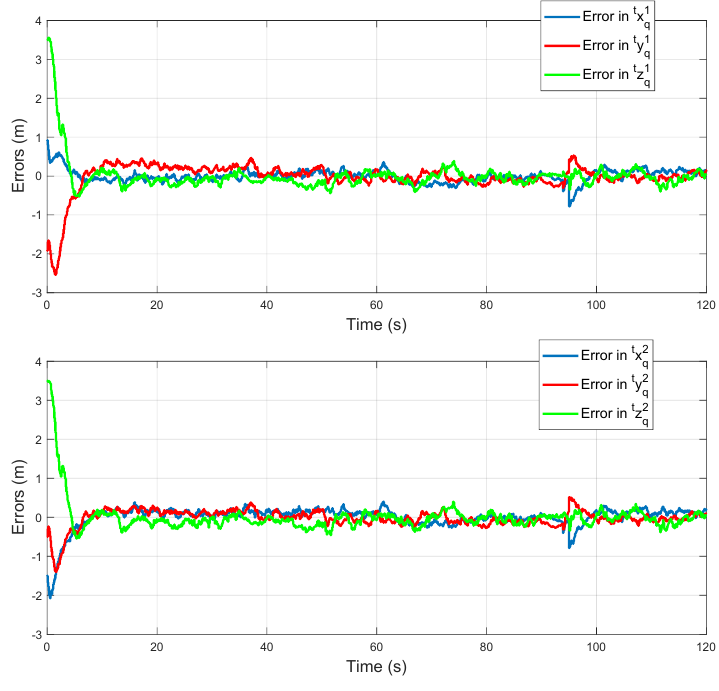
Figure 11. Errors in t x q i